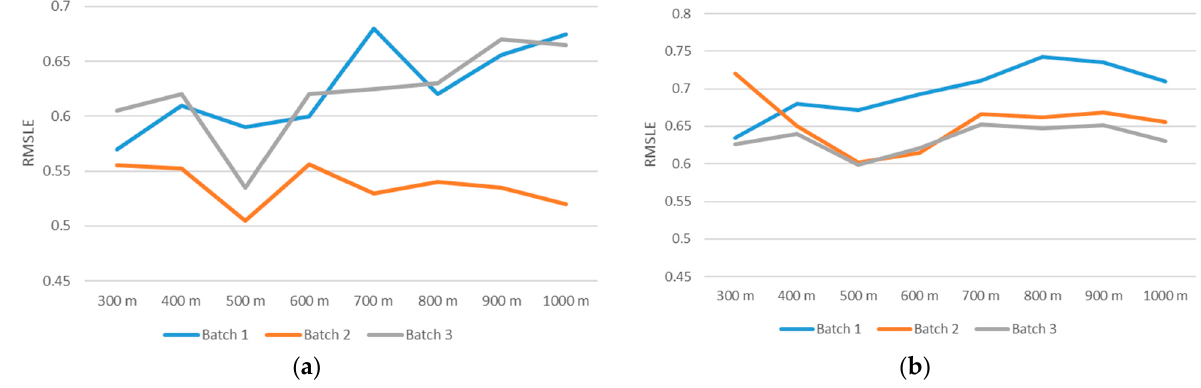
Figure 8. Results of different regions for feature extraction in ( a ) Rental and ( b ) Drop-off.